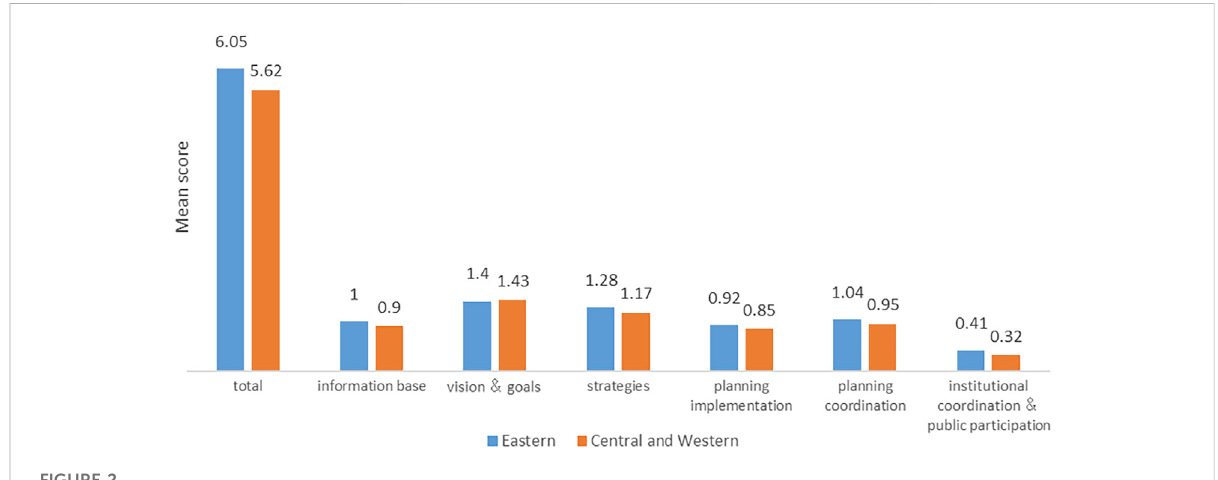
FIGURE 2 Comparison of eastern region with central and western regions.